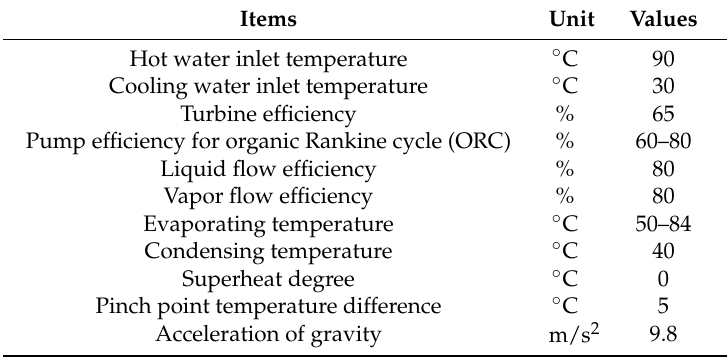
Table 2. Specified conditions in the comparative